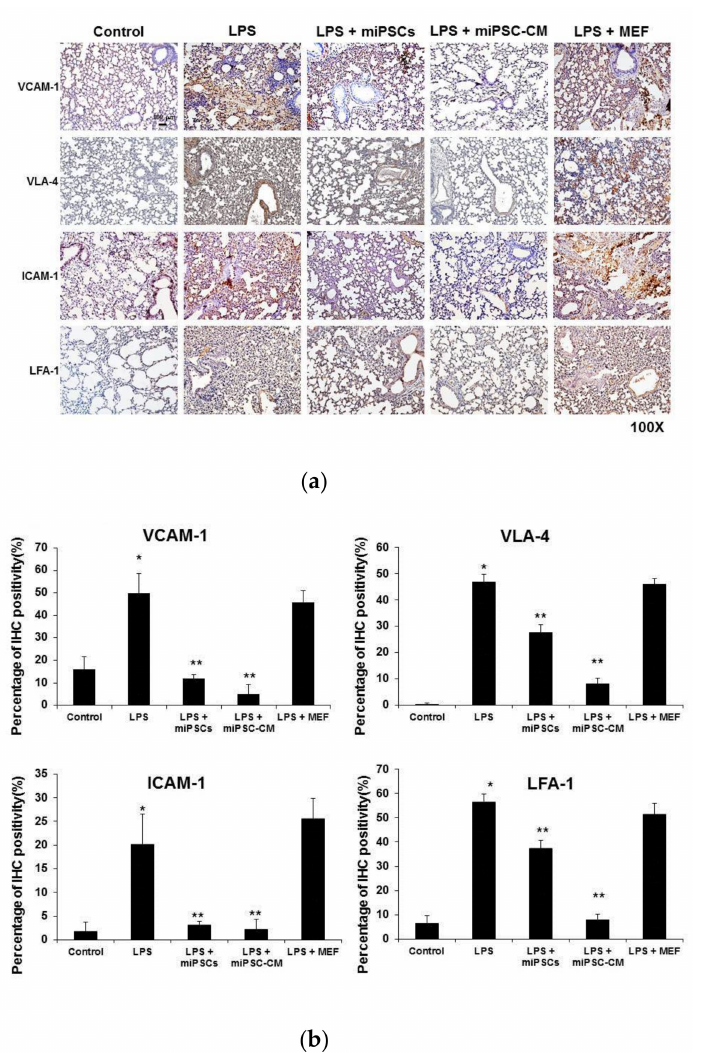
Figure 2. Administration of LPS increased the expression of adhesion molecules (including VCAM- 1, VLA-4, ICAM-1, and LFA-1) in lung tissue. Administration of miPSCs or miPSC-CM reduced adhesion molecules in mice with LPS-induced ALI. ( a , b ) Immunohistochemistry (IHC) staining of lung sections show that VCAM-1 expression significantly increased following the administration of LPS compared to control mice. In contrast, the expression of VCAM-1 in ALI mice was reduced by intravenous delivery of miPSCs or miPSC-CM. Similarly, the expression of VLA-4, ICAM-1, and LFA-1 in the lung was increased by LPS stimulation and was inhibited by administering miPSCs or miPSC-CM. Data are presented as the mean ± SD. * p < 0.05, compared to control mice; ** p < 0.05, compared to LPS-induced ALI mice; n = 6 per